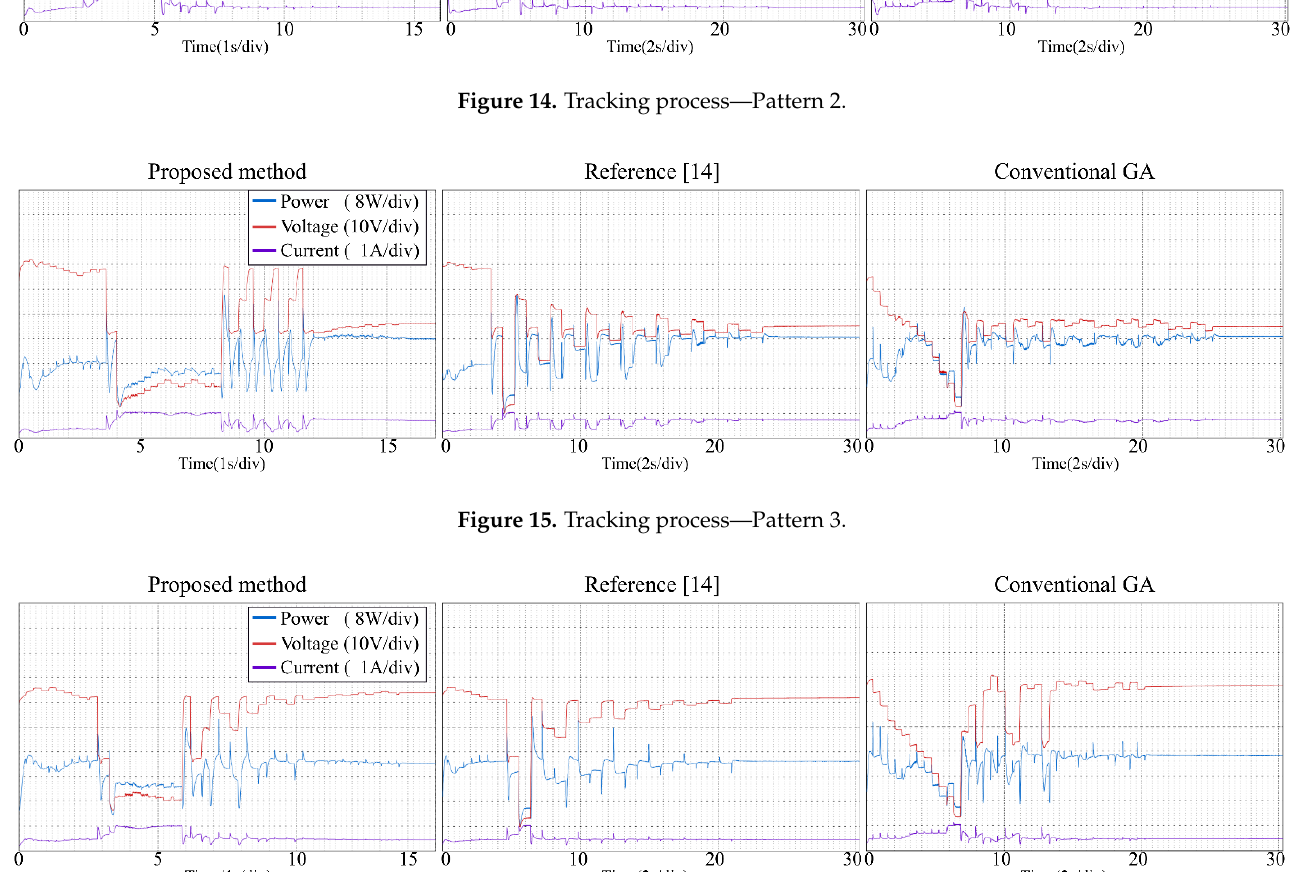
Figure 16. Tracking process—Pattern 4.